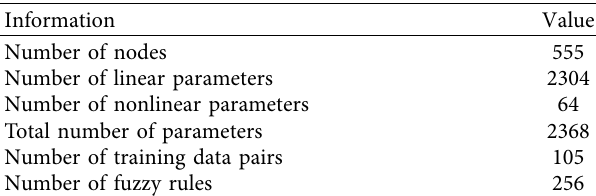
Table 5: Detailed information about the selected ANFIS model.